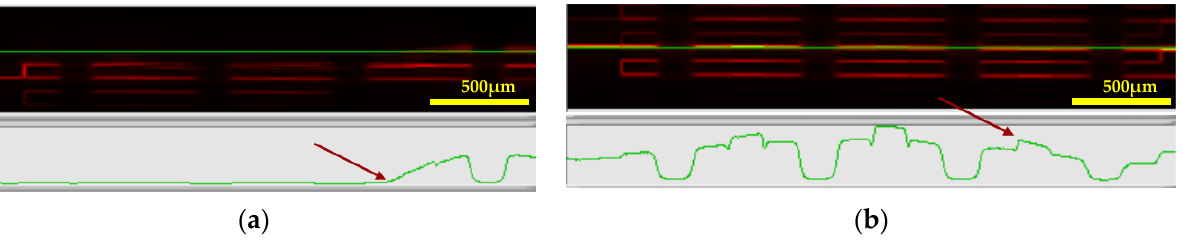
Figure 8. RF scan with two probes on failed sample: ( a ) F = 42.5 MHz; ( b ) F = 48.0 MHz. The yellow cross shows the position of the possible open location, as shown in